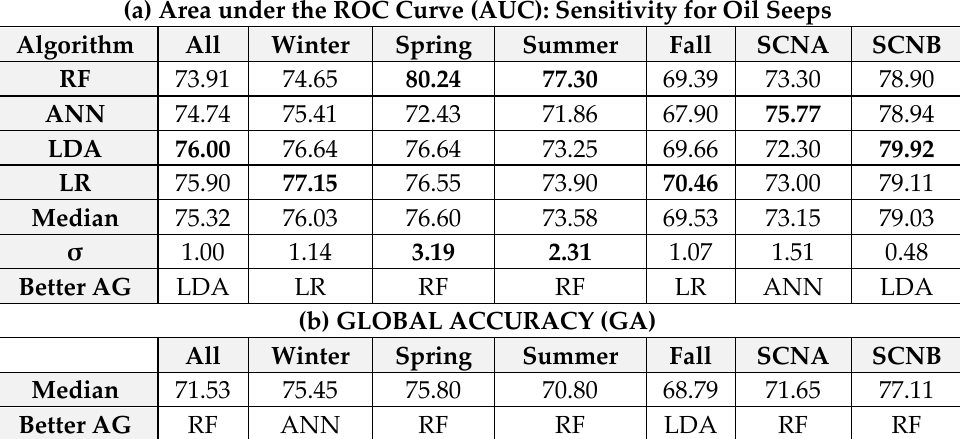
Table 9. ( a ) Median accuracies and standard deviations for the AUC(s) from the SCM, and ( b ) the median accuracies for the global CM.